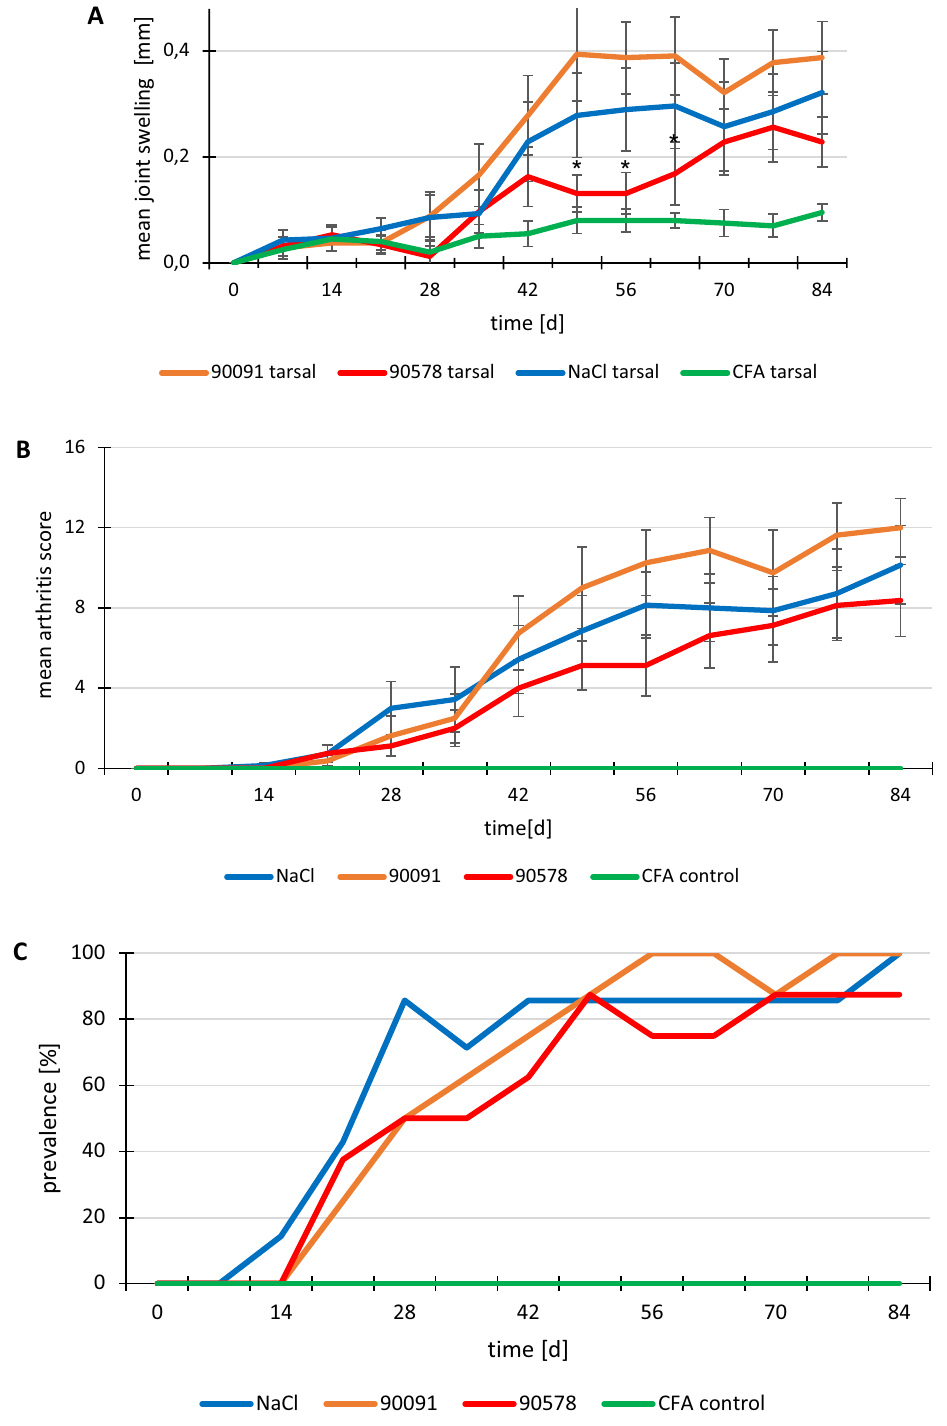
Figure 5. Clinical results of the therapy study with peptides 90091 and 90578 or NaCl. ( A ) Mean paw swelling of tarsal joints, ( B ) mean arthritis score, ( C ) prevalence of arthritis. Treatments: red: peptide 90578 (N = 8 independent animals); orange: peptide 90091 (N = 8); blue: NaCl (N = 7); green: CFA-immunized negative controls (N = 2); *p < 0.05 (all values compared to NaCl control mice); error bars indicate